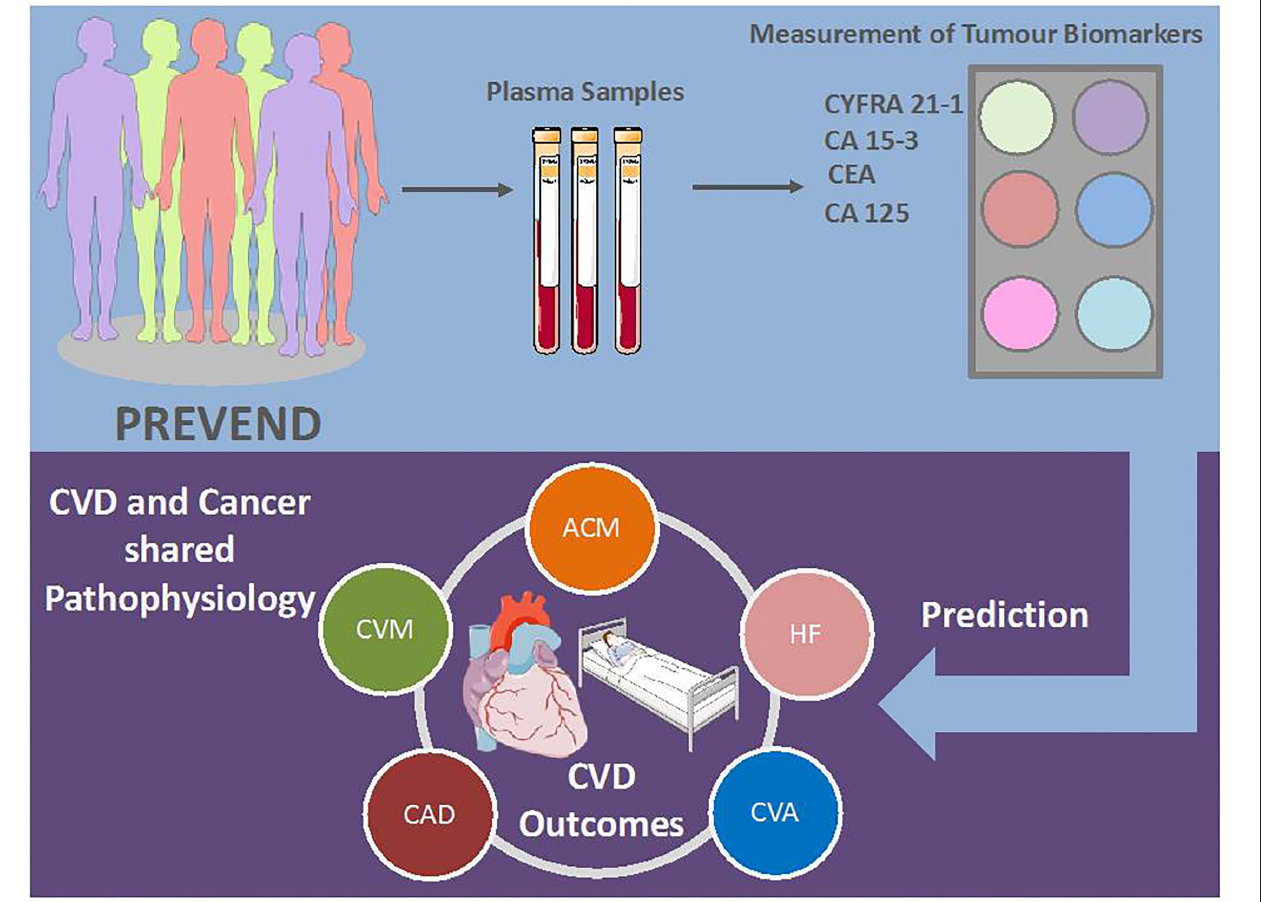
FIGURE 2 | Possible use of tumour biomarkers in clinical practise. CVD, cardiovascular disease; AFP, alpha-fetoprotein; CA, cancer antigen; CEA, carcinoembryonic antigen; CYFRA, cytokeratin fragment; ACM; all-cause mortality; CVM, cardiovascular mortality; HF, heart failure; CAD, coronary artery disease; CVA, cerebrovascular accident. Illustration elements are from Smart Servier Medical